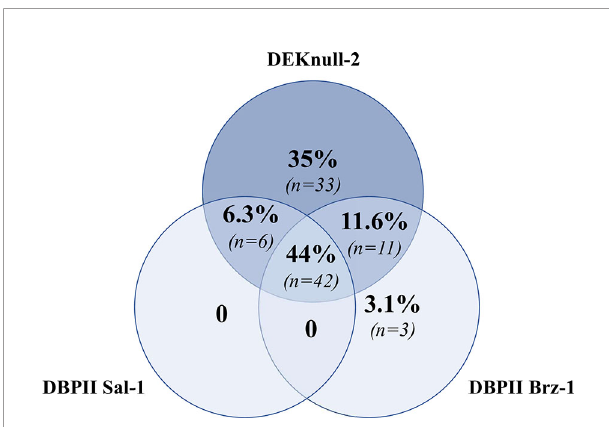
FIGURE 3 | Venn diagram showing overlap positivity for DBPII constructions in the DBPII-based multiplex fl ow cytometry assay. Venn diagram was built with 95 plasma samples that were positive for at least one DBPII construction in the multiplex assay, which included naturally occurring DBPII variants (DBPII Sal-1 and Brz-1) and the engineered DBPII immunogen (DEKnull-2). Each circle contains the proportion and number of positive samples for DEKnull-2 (dark blue) and either DBPII Sal-1 or DBPII Brz-1 (light blue). Proportions/numbers of samples that were positive for more than one antigen are displayed in circle